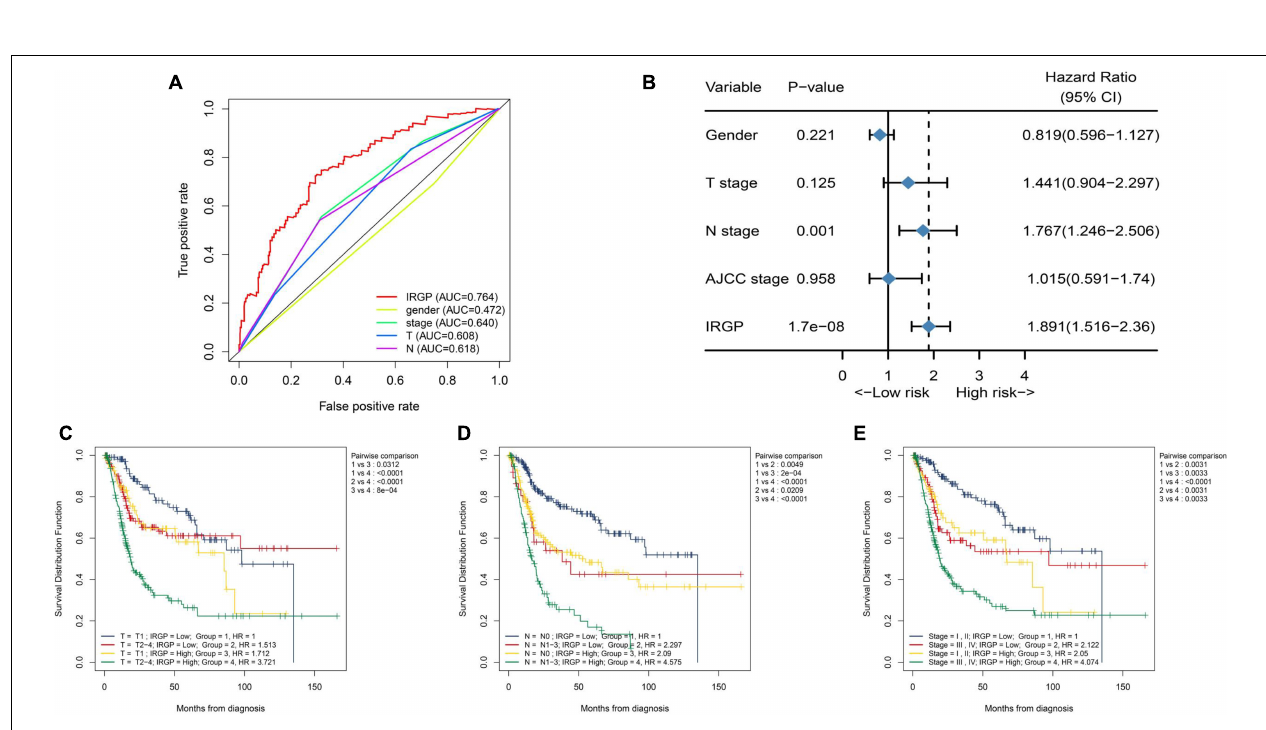
FIGURE 3 | Relationship between risk score and clinical characteristics. (A) ROC curve of gender, WHO stage, AJCC-T stage, AJCC-N stage, and risk score with their respective AUC values. (B) Multivariate Cox regression analysis. KM curves of OS for patients in TCGA cohort stratified by IRGP signature, AJCC-T stage (C) , AJCC-N stage (D) , and WHO stage (E) . ROC, receiver operating characteristic; WHO, World Health Organization; AJCC, American Joint Committee on Cancer; AUC, area under the curve; KM, Kaplan–Meier; OS, overall